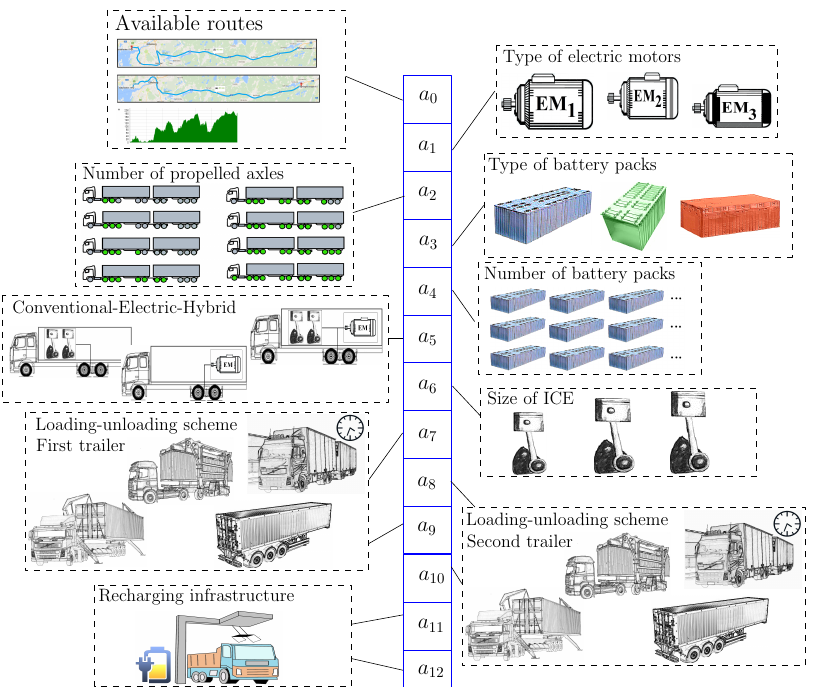
Figure A1. Schematic of vehicle-infrastructure design variables and their corresponding range for a mission comprising two